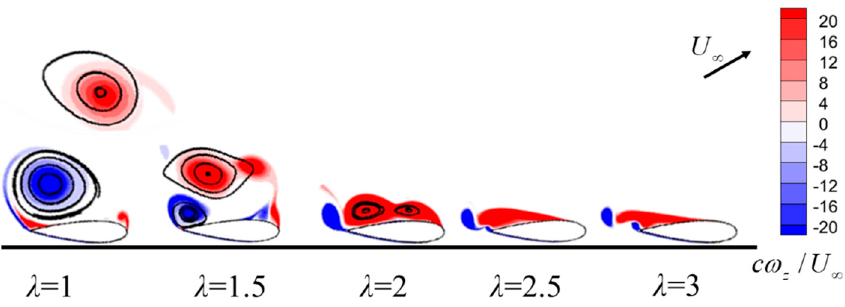
Figure 15. Vorticity contours with different λ at θ = 120°.